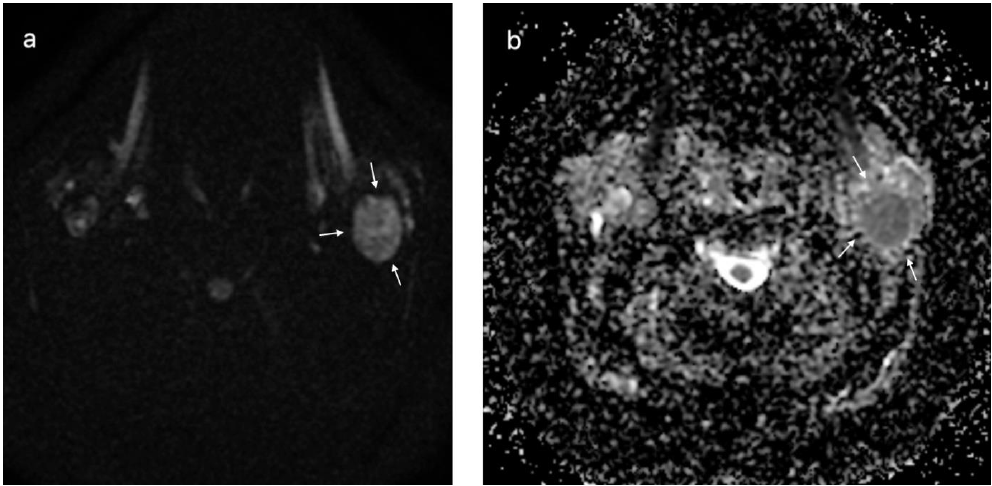
Figure 7. Warthin tumor of the left parotid gland (white arrows); DWI sequences ( a ) with ADC map ( b ) showing a value of 0.72 × 10 − 3 mm 2 /s.